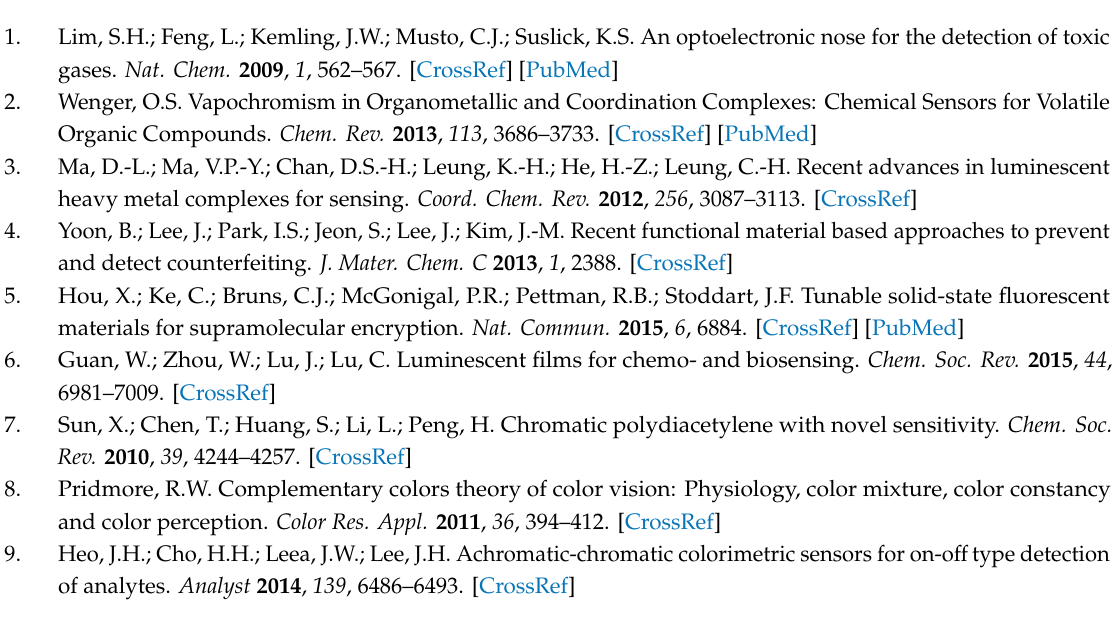
Figure S1. 31 P NMR spectrum of the depolymerizing mixture of 1, Figure S2. Emission spectra of depolymerized mixtures of 1 and of 3, Figure S3. SEC analyses of 1 with various HCl concentration, Table S1. The QY after the depolymerization of 1, Figure S4. (a) Time-course of emission spectra of the reaction mixture of 1 with HCl. (b) Photographic images of the emission behavior of the reaction mixture of 1 with HCl, Figure S5. Emission spectra of 1 before reactions with HCl gas, Figure S6. Emission spectra of 1 in CHCl 3 before irradiation and after UV irradiation, Figure S7. SEC analyses of 1 after reactions with HCl gas and of 2 after reactions with HCl gas, Figure S8. Emission spectra of polymer films of 2 before and after reaction with HCl gas, Figure S9. Emission spectra of 1 after reactions with various gases, Figure S10. SEC analyses of 1 after reactions with various gases, Figure S11. (a) Photographic images of polymer films of 1 film before and after the reaction with HCl gas spray. (b) Illustration of the experiment, Figure S12. SEC analyses of 1 under HCl gas with various reaction conditions, Figure S13. (a) Emission spectra and (b) photographic images of the reaction mixture of 1 before and after reaction with 5000 ppm HCl under UV irradiation, Figure S14. Emission spectra of the reaction mixture of 1 before and after reaction with 500 ppm HCl under UV irradiation, Figure S15. 1 H NMR spectrum of 4, Figure S16. 13 C NMR spectrum of 4, Figure S17. 31 P NMR spectrum of 4, Movie S1. Real-time HCl gas